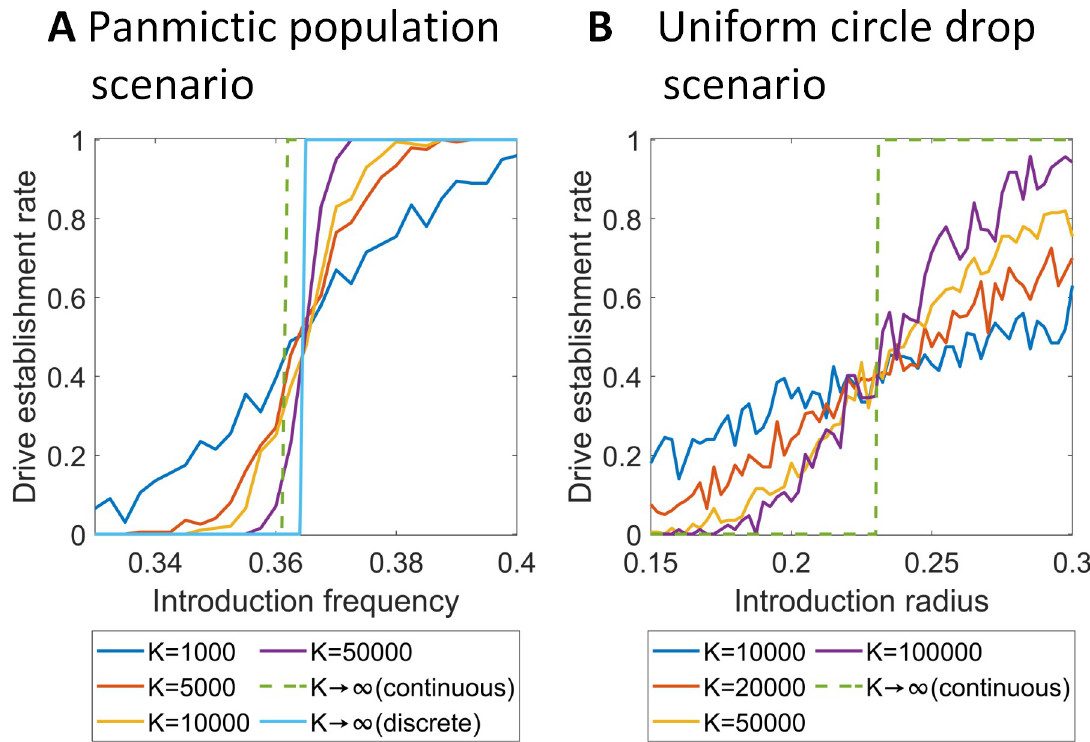
Fig 7. Effect of population size on critical drive thresholds. Results from simulations are shown, as well as results from continuous or discrete-generation math models. Drive fitness and efficiency are 1. A : Probability drive allele will be successfully established in a 1-deme panmictic model. B : Probability drive allele will successfully establish in a uniform circular 80% release in continuous space with a dispersion of 0.03. Simulations are repeated 200 times for each set of parameters.